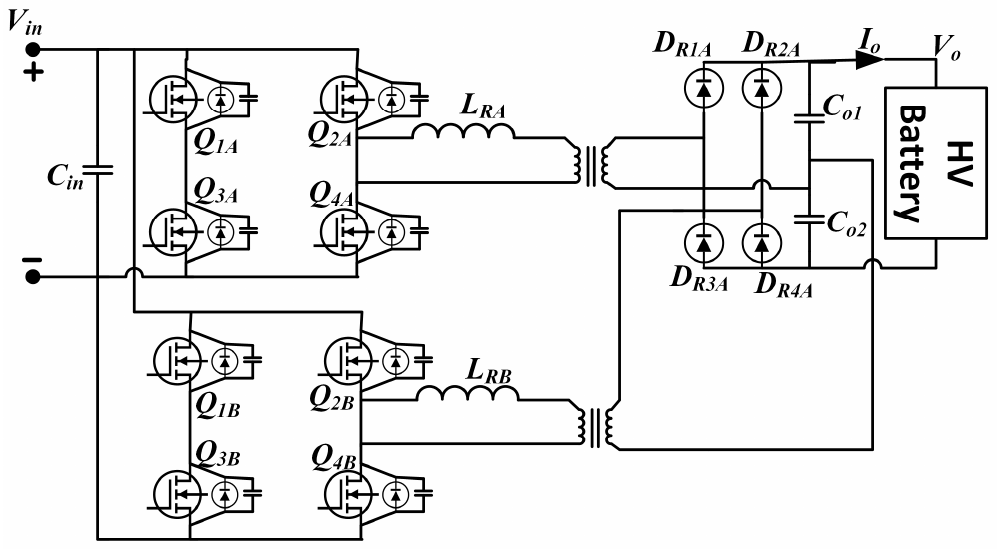
Figure 49. Interleaved ZVS FB Converter with Voltage Doubler [46].